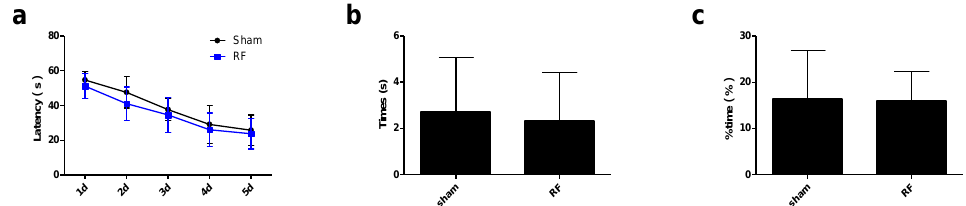
Figure 5. Effects of RF field exposure on the spatial learning and memory. ( a ) the escape latency in training phase (within group: df = 4, F = 68.17, P < 0.001; between groups: df = 1, F = 3.185, P = 0.085), ( b ) the number of times crossing the platform area in probe phase (t = 0.290, df = 18, P = 0.775), ( c ) the time spent in the target quadrant in probe phase (t = 0.127, df = 18, P = 0.900). All data are presented as mean ± SD. No significant difference was observed between the sham and RF groups ( P > 0.05).